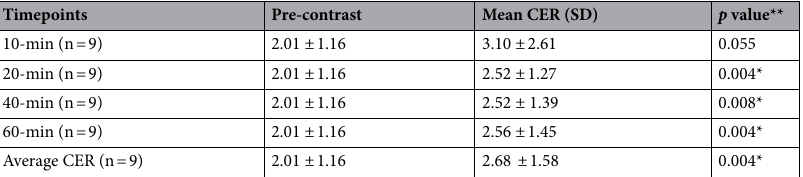
Table 1. Gadoxetate disodium enhancement over time in metastatic CRPC subgroup. Metastatic CRPC takes up gadoxetate disodium and demonstrated delayed enhancement. *Significant p value ** Statistical test used—Wilcoxon test.